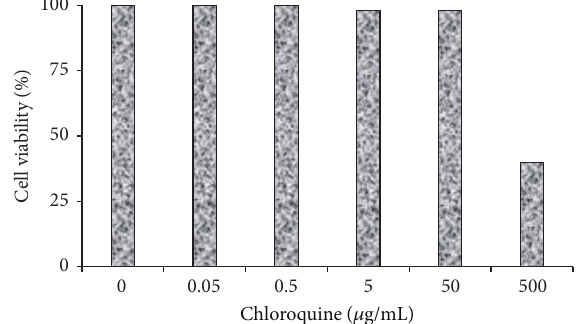
Figure 1: The effect of CLQ on the cytotoxicity in C6/36 cells. Concentrations equal to or higher than 500 𝜇 g/mL (CLQ) were highly cytotoxic to C6/36 cells, while concentrations equal to or lower than 50 𝜇 g/mL (CLQ) did not induce significant cytotoxicity.